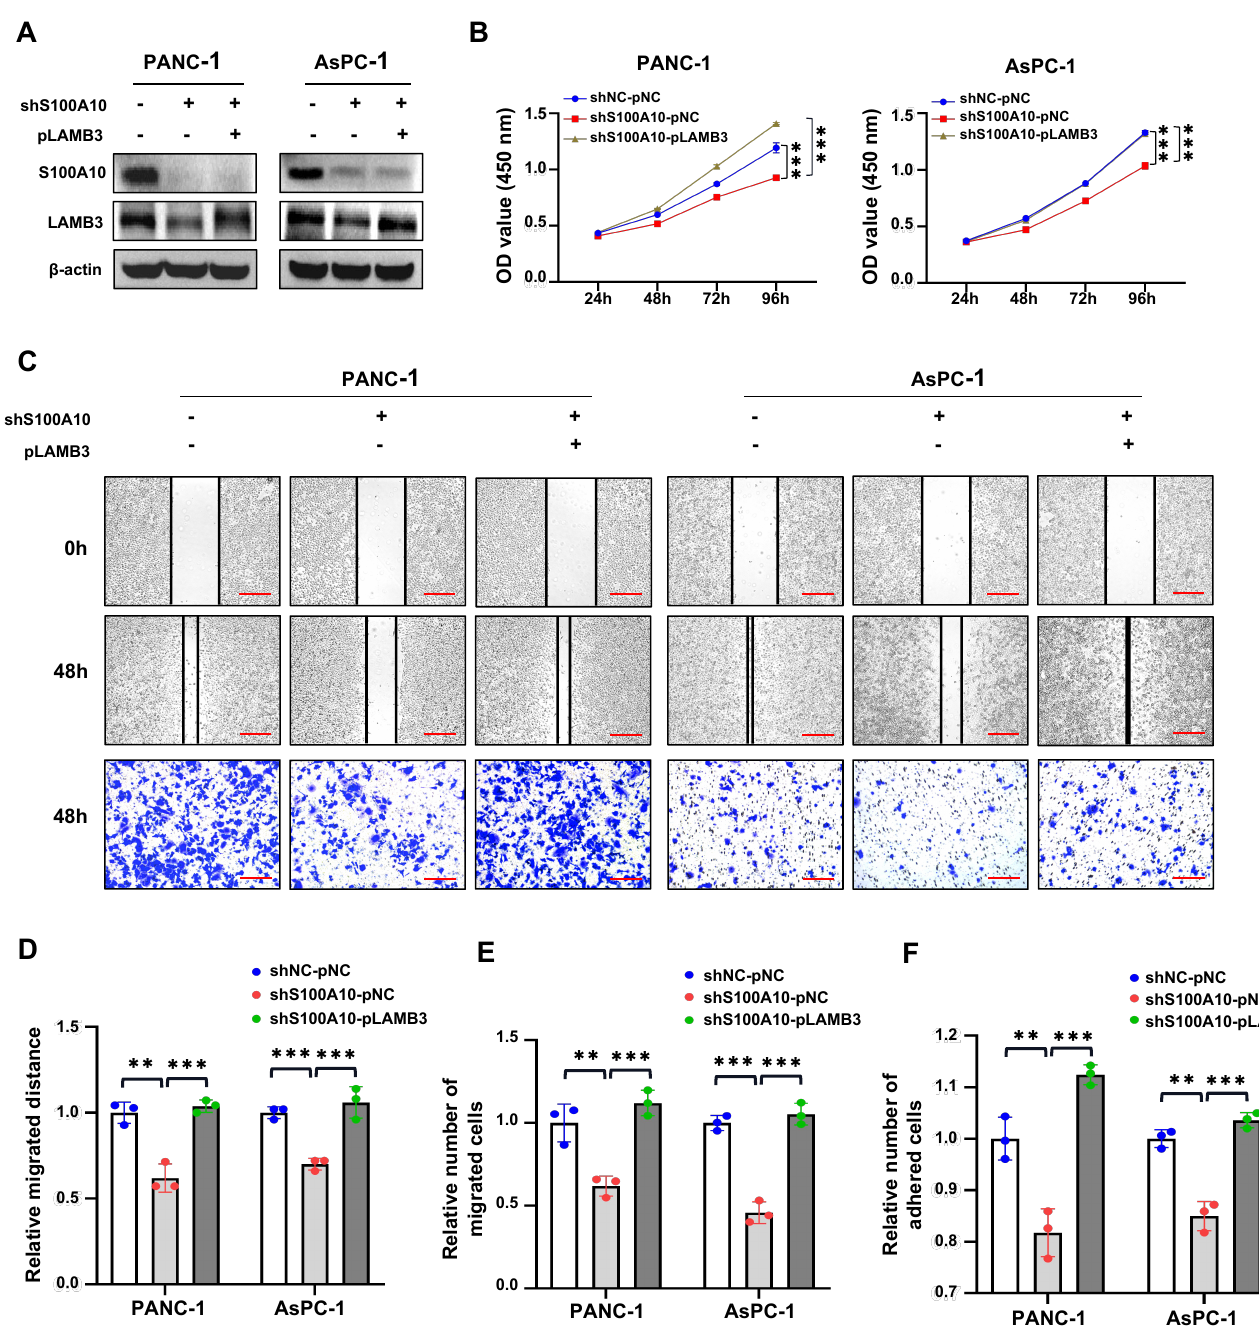
Figure 7. The re-expression of LAMB3 reverses the inhibitory effect of S100A10 knockdown on PDAC cells proliferation, migration and adhesion in vitro. ( A ) The S100A10 stably knocked-down (shS100A10) and control (shNC) PANC-1 and AsPC-1 cells were transfected with a plasmid to over-express LAMB3 (pLAMB3) or control plasmid (pNC) for 48 h. Western blotting was used to measure the expression of indicated proteins in the control (shNC-pNC), S100A10 stably knocked- down (shS100A10-pNC) and S100A10 stably knocked-down plus LAMB3-reexpressed (shS100A10- pLAMB3) PANC-1 and AsPC-1 cells. ( B ) After transfection with pNC or pLAMB3 for 48 h, cell proliferation was determined by CCK-8 assay in shNC-pNC, shS100A10-pNC and shS100A10-pLAMB3 PANC-1 and AsPC-1 cells at indicated time points ( n = 3). ( C – E ) After transfection with pNC or